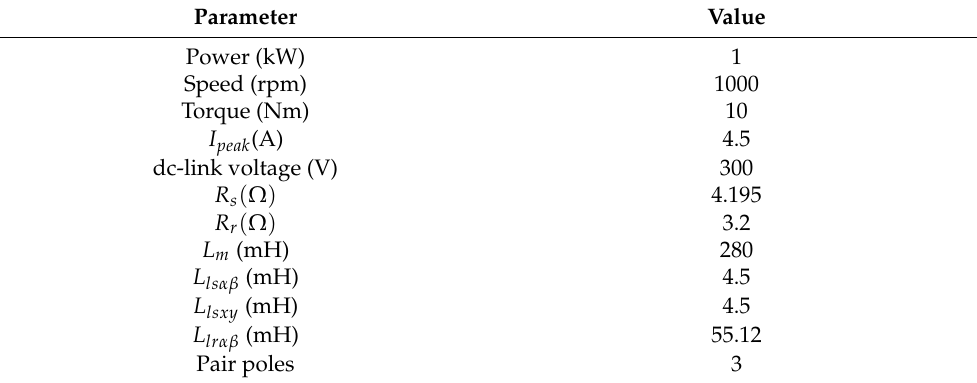
Table 1. Electric drive parameters.